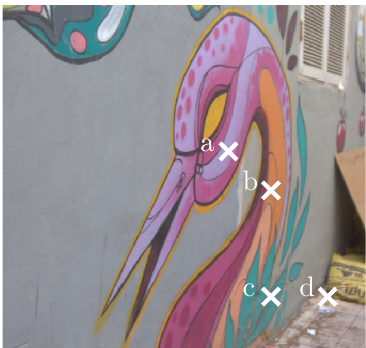
Figure 9. An exemplary image from the test set (in sRGB) which is associated with the reconstruction results shown in Figure